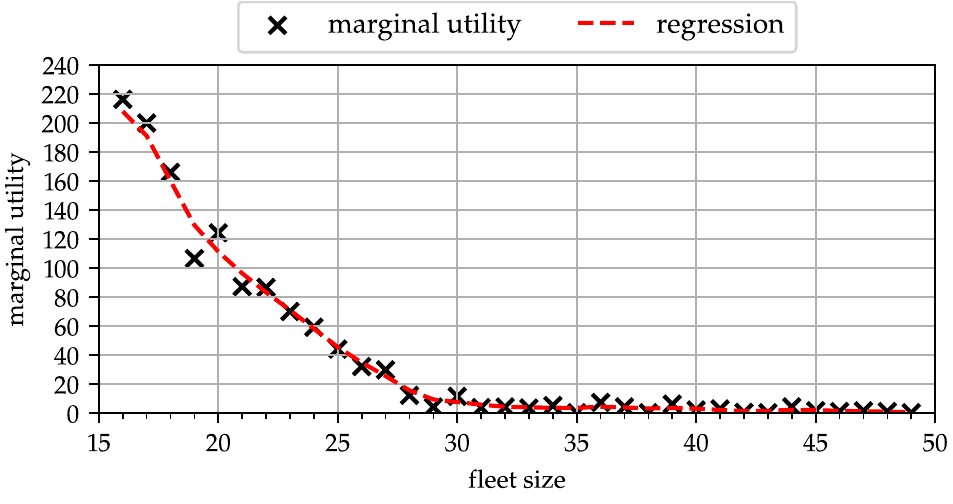
Figure 5. Marginal utility of increased